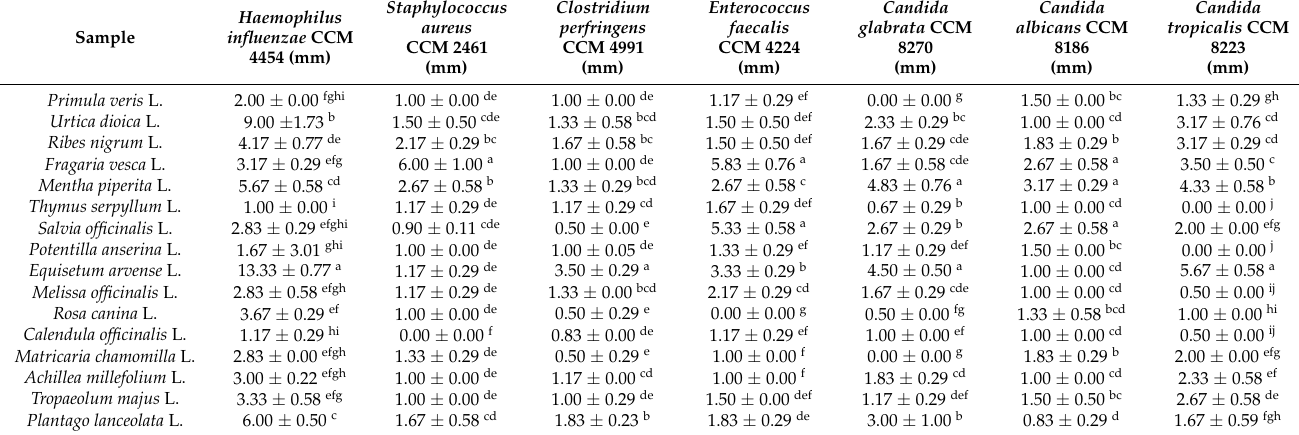
Table 4. Antimicrobial activity of tested medicinal